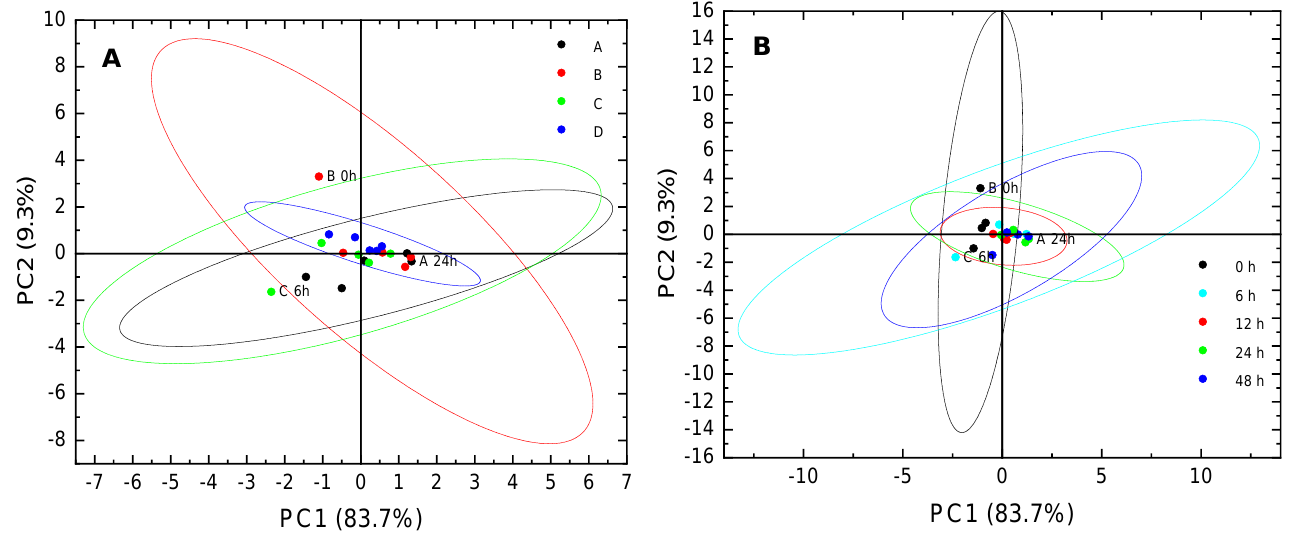
Figure 4. PCA of the different FTIR spectra of ( A ) different blends (MD DE 2:MD DE 21:PP — A (80:10:5), B (80:10:10), C (80:10:15), and D (80:10:20)) and ( B ) different heating times. (Labelled spectra are outliers, and the confidence ellipsoids represent in each case a probability of 95%).